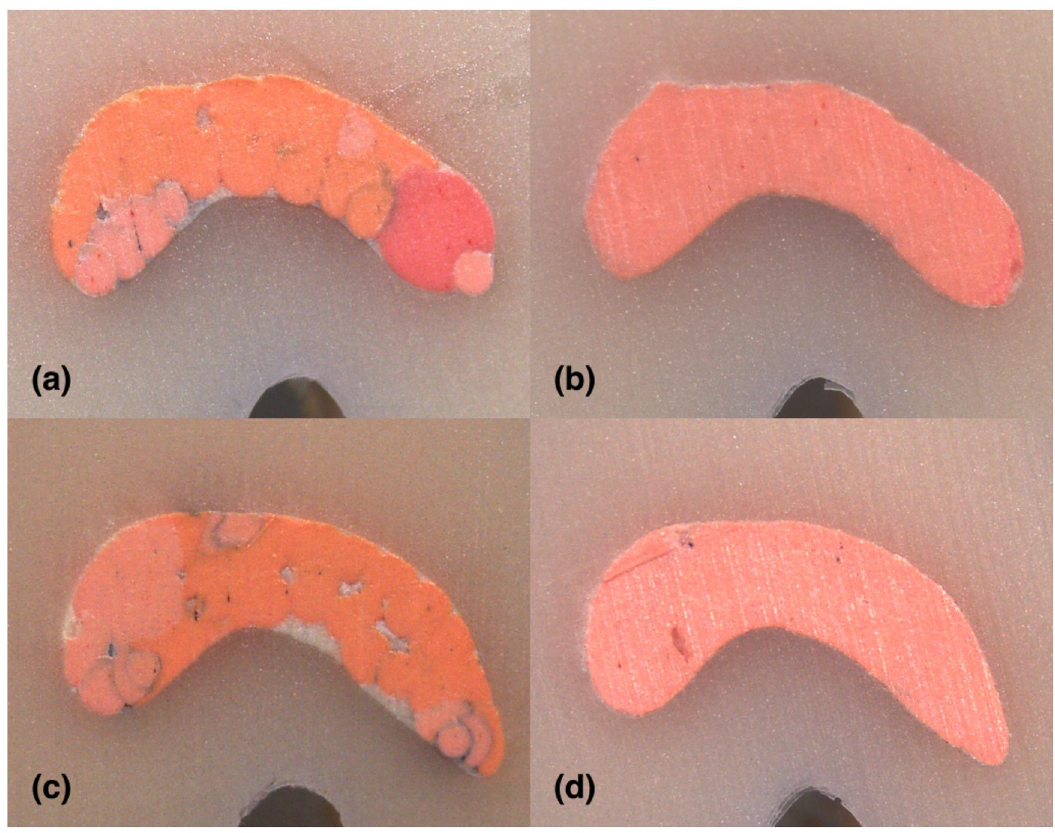
Fig 7. Stereomicroscope images of 8 mm sections instrumented with Hyflex EDM: (A) LC (B) CW; Stereomicroscope images of 8 mm sections instrumented with Reciproc Blue: (C) LC (D) CW in C1-type.